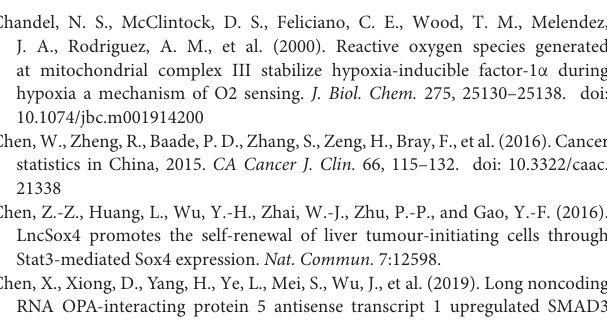
Supplementary Figure 1 | Validation of Hela, Caski, and Siha cell line knocking down OIP5-AS1 using RT-qPCR (A) and RT-qPCR (B) . Supplementary Figure 2 | Validation of Hela cell line overexpressing IDH2 using western blot (A) and cellular immunofluorescence (B)